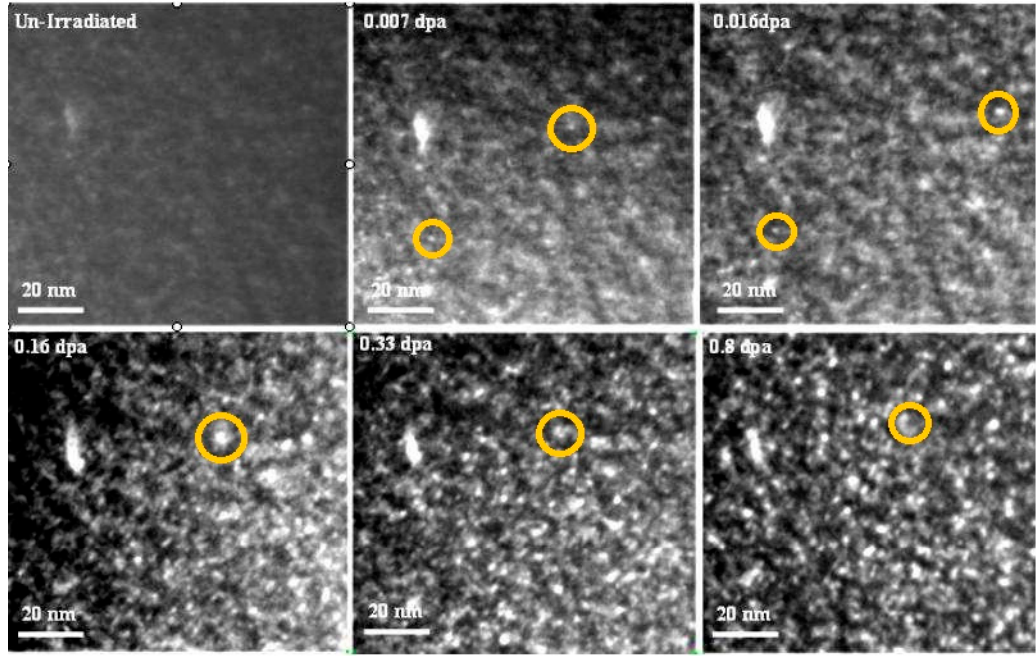
Figure 3. Series of dark field micrographs, taken during in situ irradiation experiment on Zircaloy-2 at 773 K, showing the formation of <a>-type loops. The bright dots are recognized as dislocation loops, among which a representative loop was circled in each dose.